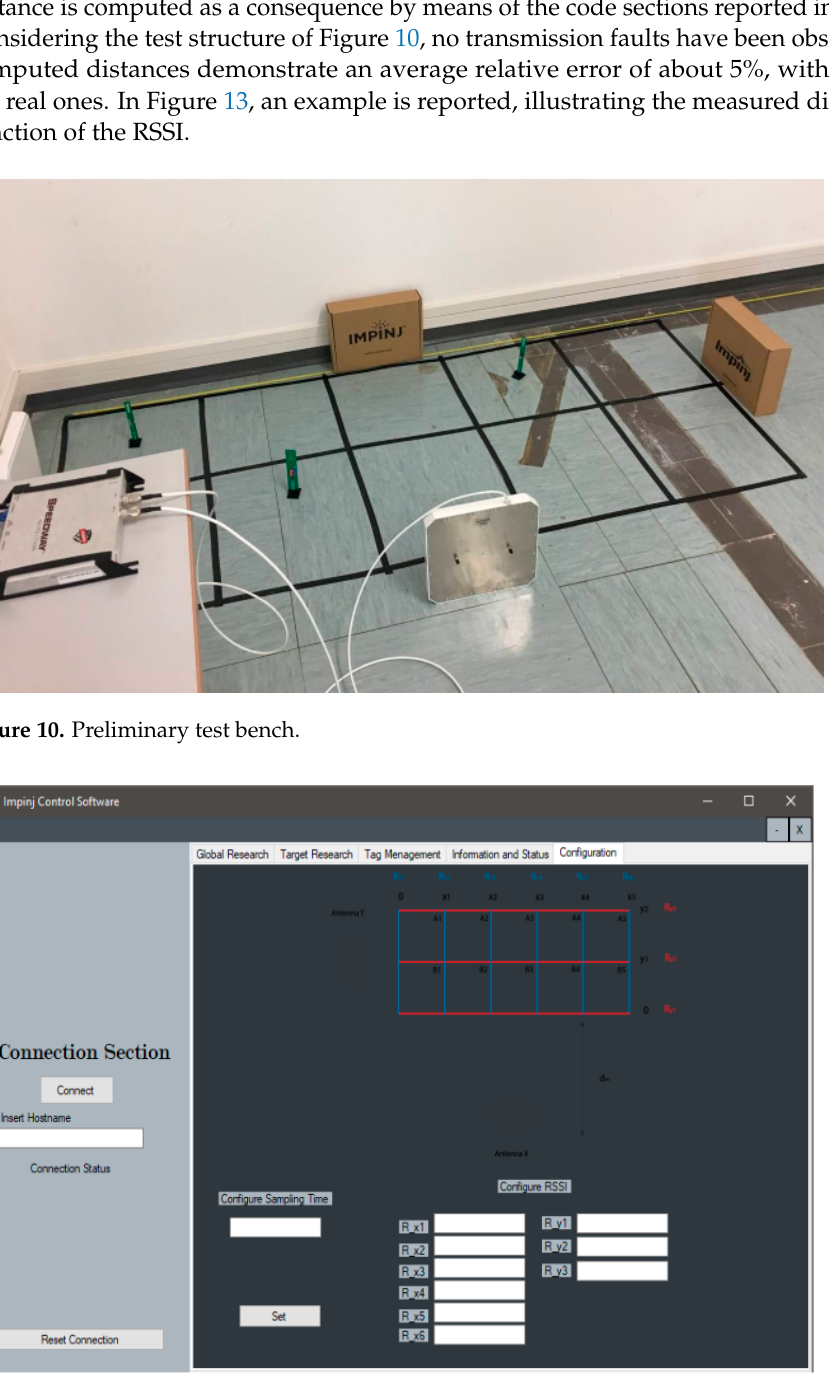
Figure 12. Code sections for RSSI and distance calculation. Figure 13. Example: Distance versus RSSI (absolute values in dBm). Measurements (dots) and fitting line (solid line).